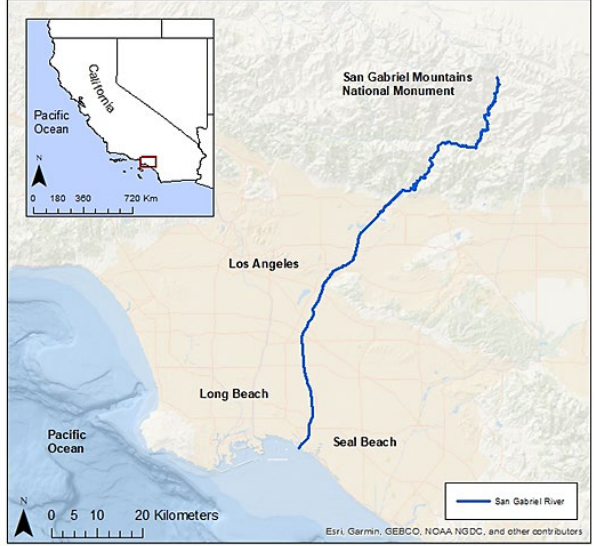
Figure 1. San Gabriel River, Southern California, USA. Green turtle monitoring sessions through the Aquarium’s CS program were conducted at 10 shoreside observation stations located along a 2.4-km (1.5 mi) stretch of the lower SGR (Stations 1 through 10, Figure 2). Each station is between approximately 50 and 60 m in length. Station 6.5 is an 11th station used specifically for training new volunteers prior to their official first session.